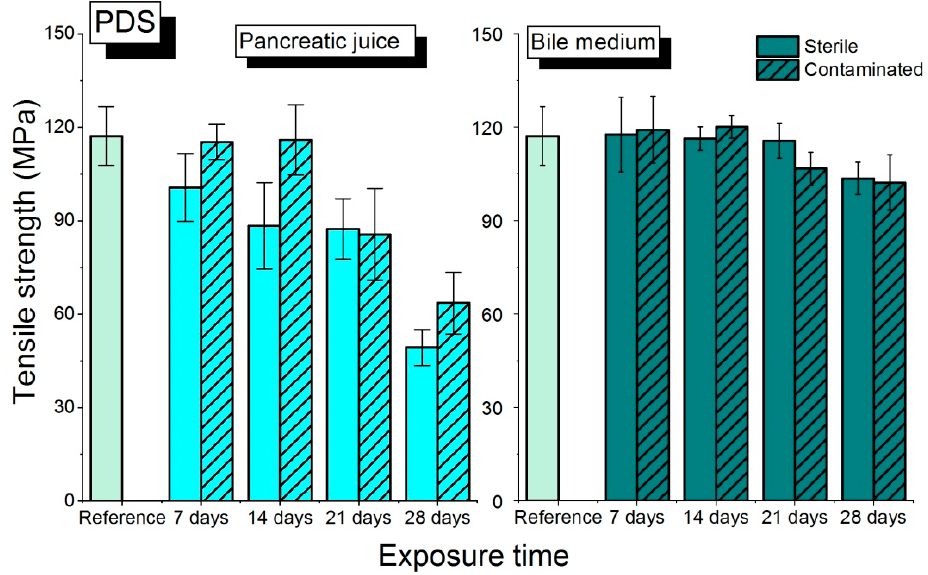
Figure 5. The results of the tensile strength of PDS sutures in bile and pancreatic juice, sterile and contaminated, in relation to the exposure time .